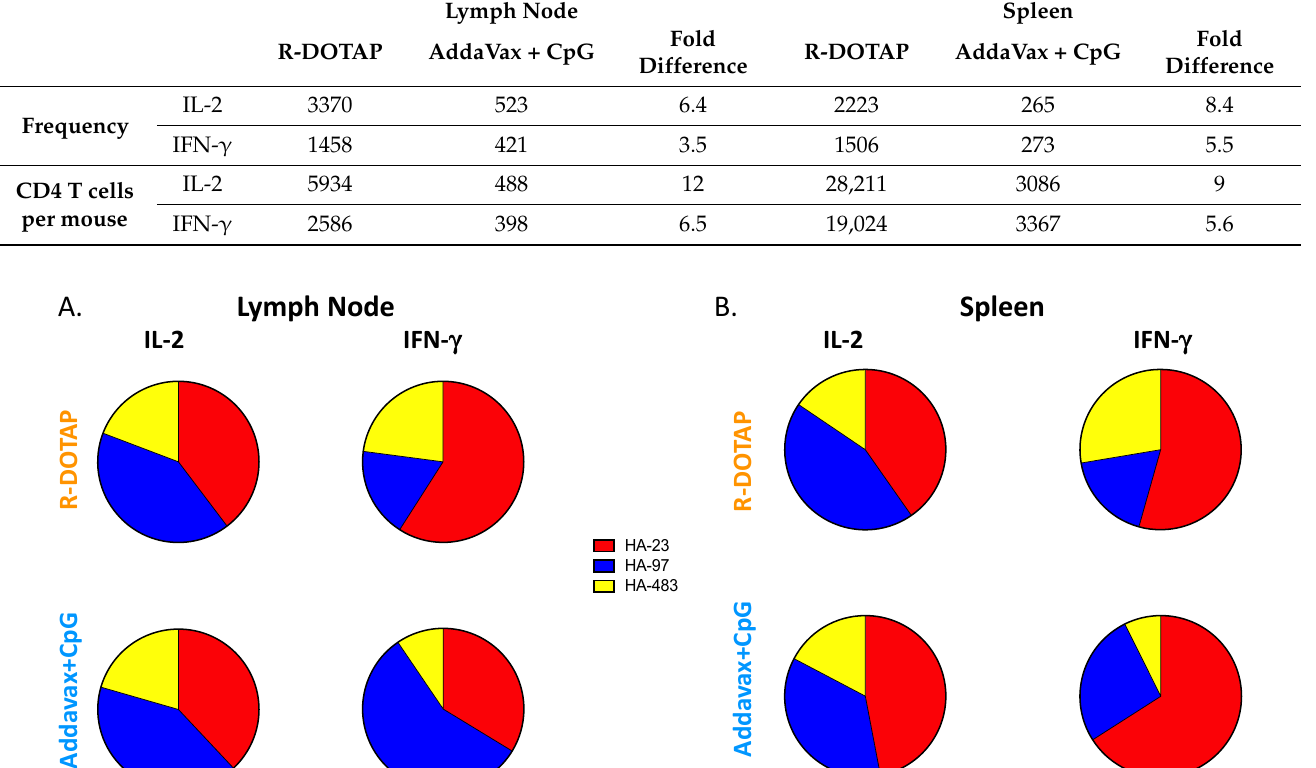
Table 3. Following subcutaneous vaccination with HA B/Malaysia in adjuvant and cytokine ELISpot using CD4 T cells isolated from the draining lymph node and spleen, as shown in Figure 3, the average frequencies of cytokine producing CD4 T cells per million corrected for background, the average number of cytokine-producing CD4 T cells per mouse corrected for background and fold differences between R-DOTAP and AddaVax + CpG were calculated.